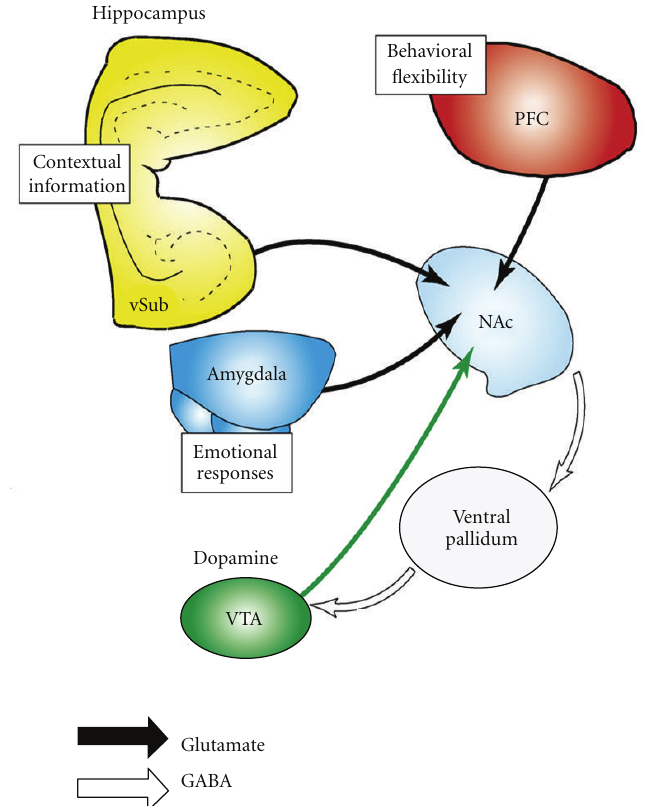
Figure 1: Hippocampal glutamatergic outputs regulate reward responses in the nucleus accumbens (modified from [1]). NAc: nucleus accumbens, PFC: prefrontal cortex, vSub: ventral subiculum, VTA: ventral tegmental area (modified from